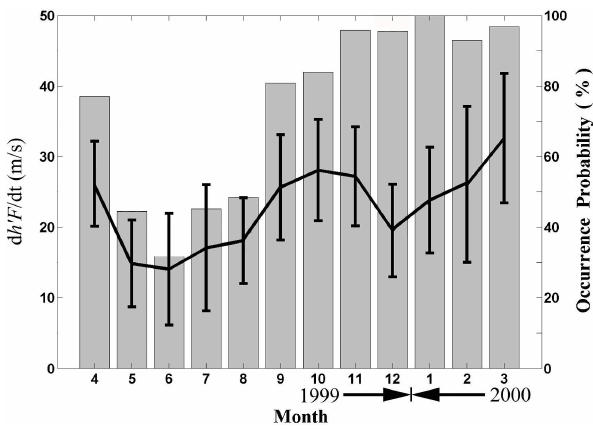
Fig. 5. Seasonal variation in the monthly mean value of the d h 0 F/dt (soild line) and the associated standard deviation (error bar) during April 1999–March 2000. The gray histogram in the background represents the occurrence probability of ESF. Two peak values of d h 0 F/dt appear at October and March, while the smallest value is at June.